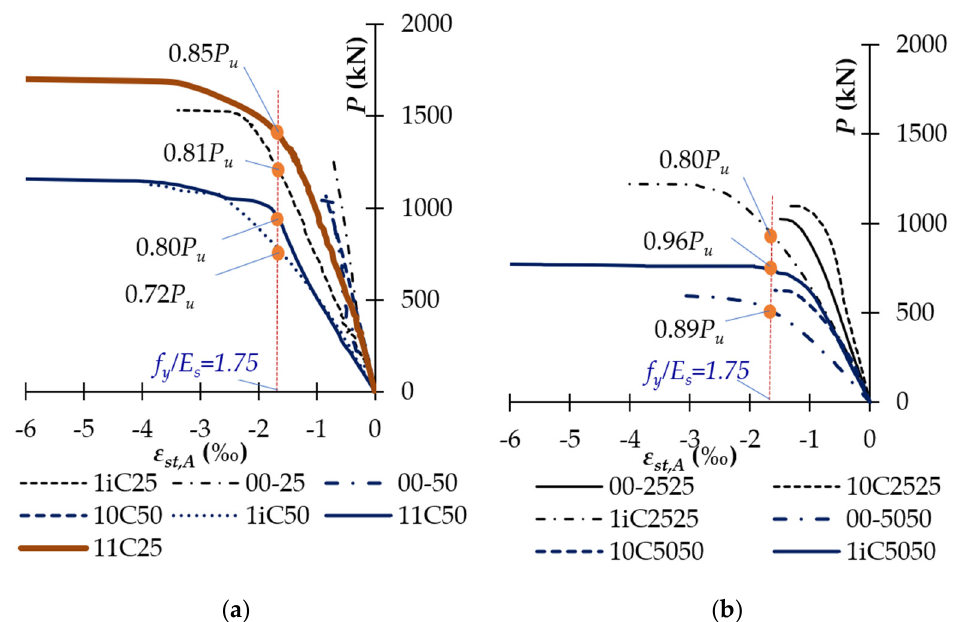
Figure 16. Relationship between the applied load and strain of longitudinal tension rebars: ( a ) Uniaxially loaded columns; and ( b ) Biaxially loaded columns. Table 4. Strains at ultimate load.